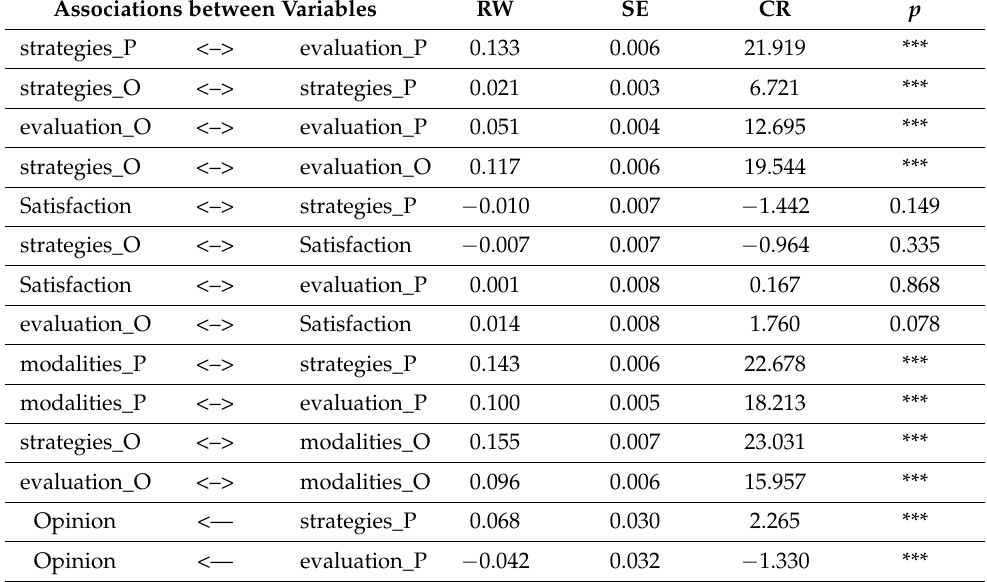
Table 6. Parameter estimates of final